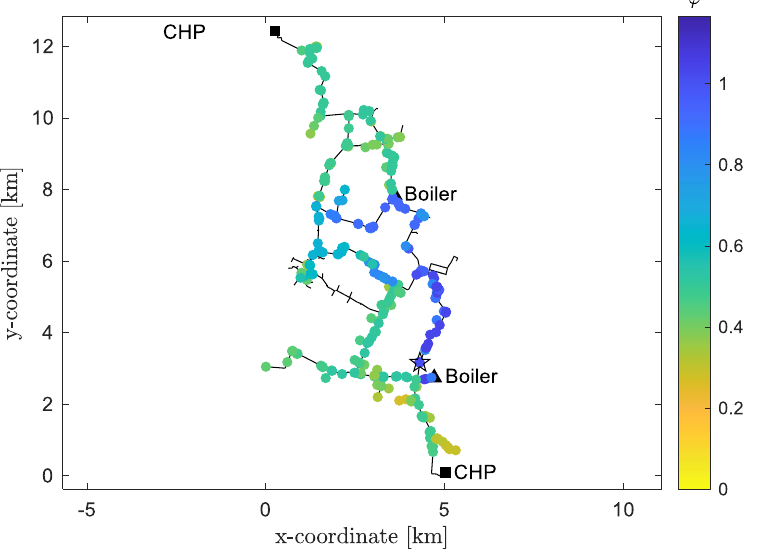
Figure 13. 𝜑̅ coefficient throughout the selected DH system, averaged on the annual operation (the star indicates the best position) − Average yearly operation with increased heating load (600 MW), base case.